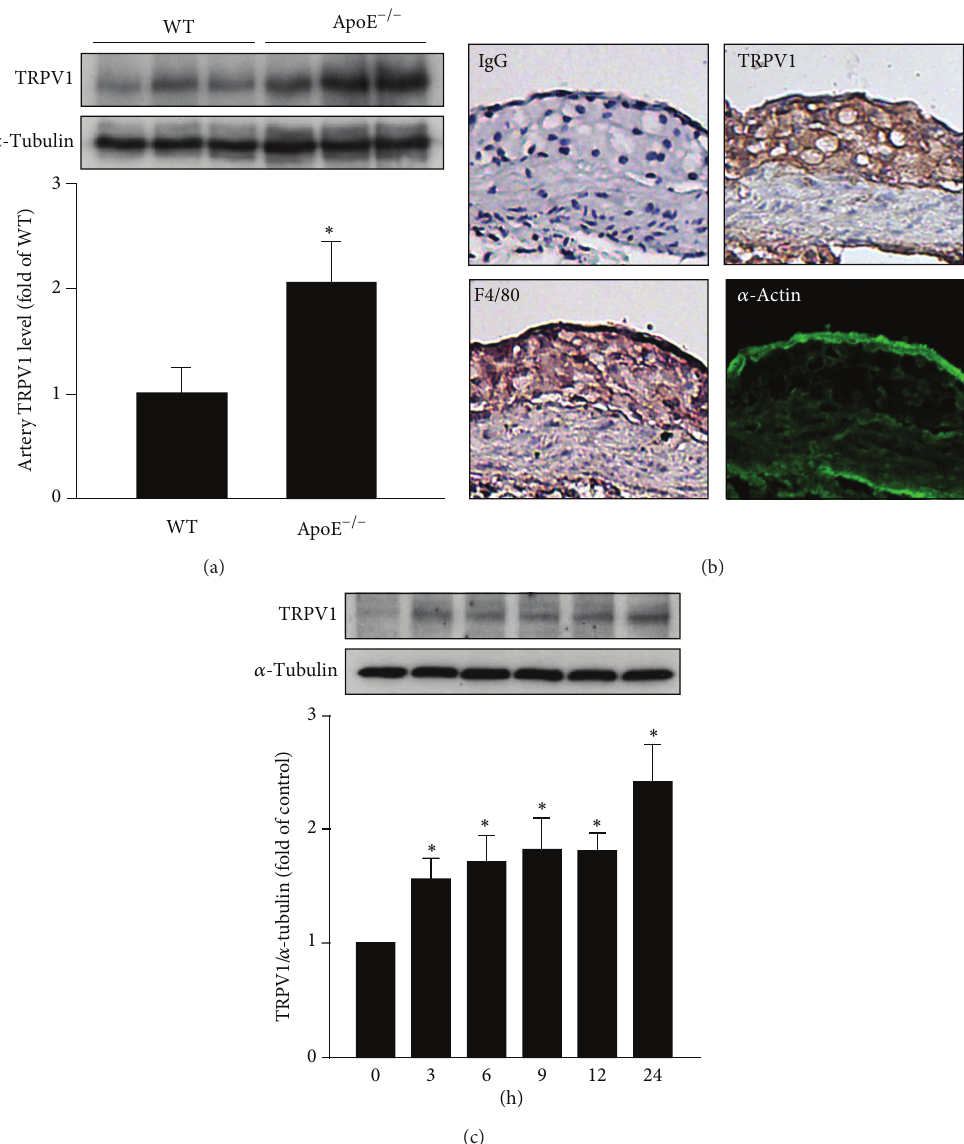
Figure 1: Expression of TRPV1 is increased in atherosclerotic lesions of ApoE −/− mice. (a) Western blot analysis of protein expression of TRPV1 in aortas from 5-month-old ApoE −/− and wild-type (WT) mice. 𝛼 -Tubulin was a normalization control. Data are mean ± SD from 6 animals. ∗ 𝑃 < 0.05 versus WT mice. (b) Immunohistochemical staining for TRPV1, F4/80 (macrophage marker), and 𝛼 -actin (smooth- muscle-cell marker) in atherosclerotic lesions of aortas from 5-month-old ApoE −/− mice. Specificity of immunostaining was confirmed with an IgG-negative control. Hematoxylin was used as counterstaining. Magnification = 100x. (c) Western blot analysis of protein expression of TRPV1 induced by oxLDL (50 𝜇 g/mL) relative to that induced by vehicle (PBS) for 0–24 h. Data are mean ± SD from 5 independent experiments. ∗ 𝑃 < 0.05 versus vehicle-treated group. 𝛼 -Tubulin was a normalization